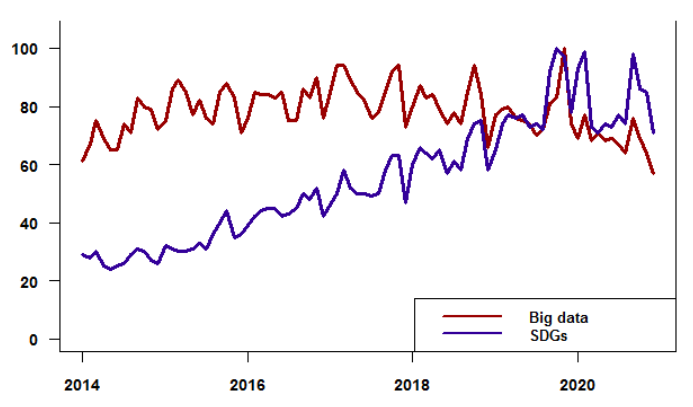
Figure 1. UN SDGs and Big Data global Google trends since